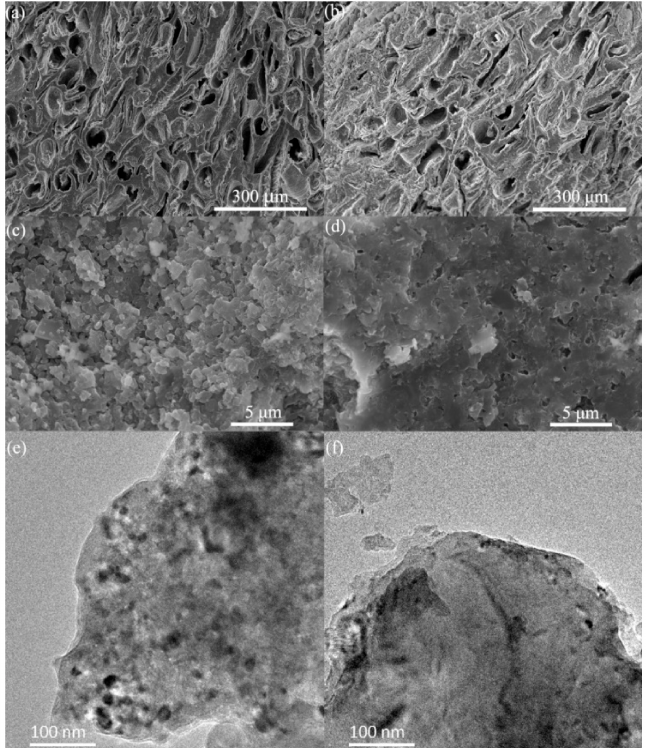
Figure 4. Microstructures of MgB 2 bulk prepared using B powders with different particle sizes ( a ) and ( c ): SEM images of Raw B; ( b ) and ( d ) SEM images of Grinding+1050 B; ( e ) TEM image of Raw B; ( f ) TEM image of Grinding+1050